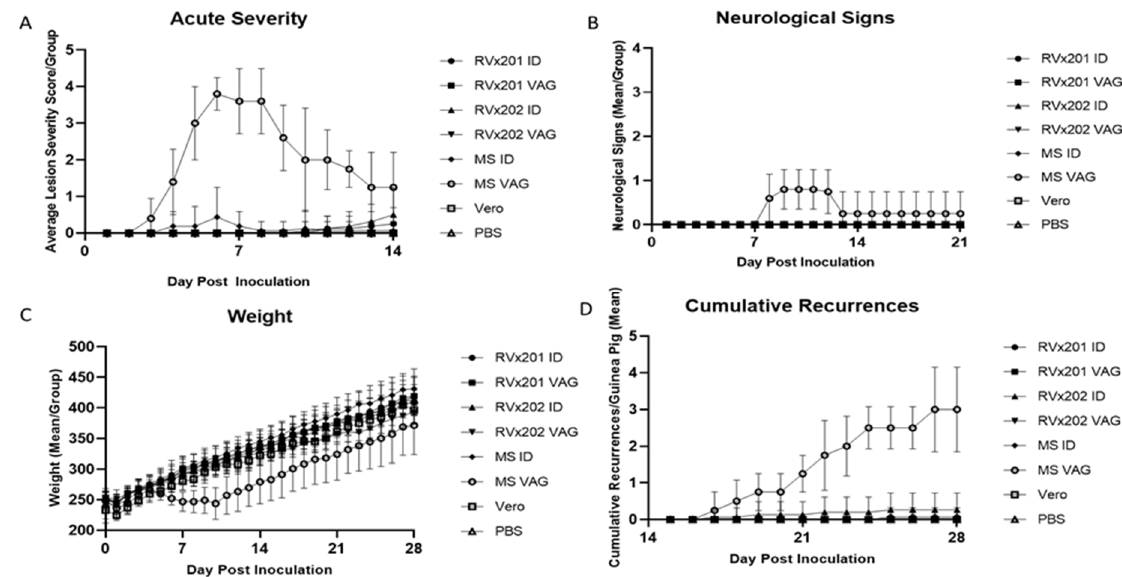
Figure 1. Clinical indicators of disease/distress in inoculated guinea pigs. Following intradermal (ID) or vaginal (VAG) inoculation of guinea pigs with RVx201, RVx202, WT HSV2 MS or ID inoculation with PBS or Vero cell lysate, guinea pigs